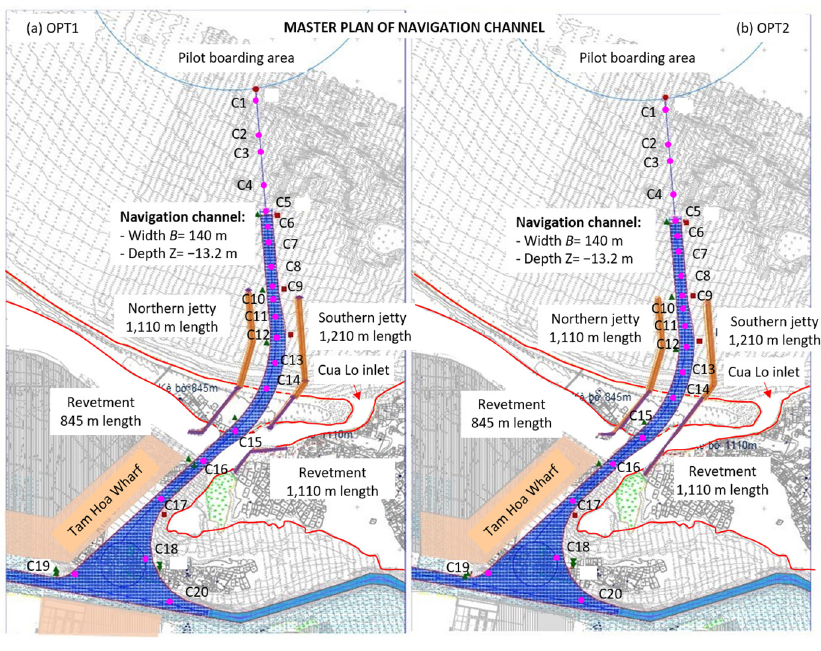
Figure 2. Master plan of navigation channel with two design alternatives of jetties ( a ) OPT1 Plan, ( b ) OPT2 Plan.